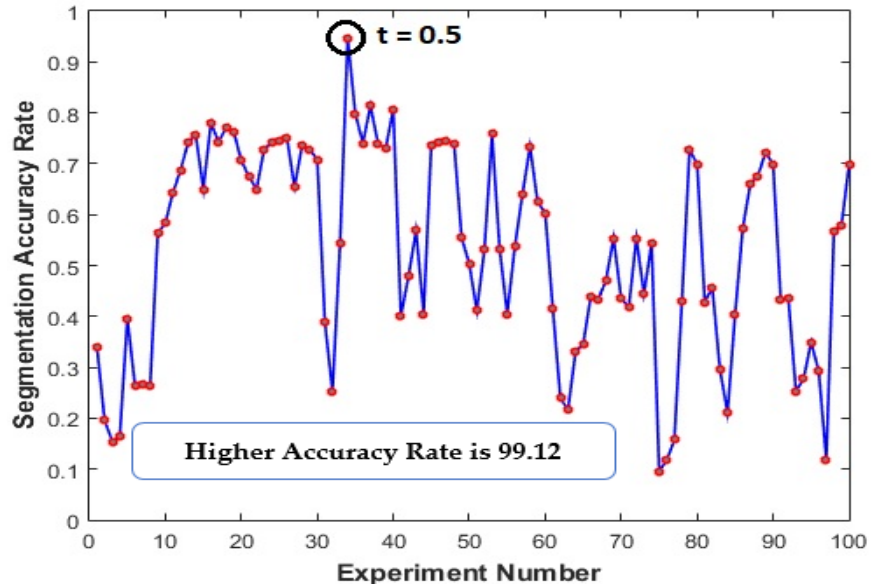
Figure 11. The segmentation accuracy obtained during 100 experiments to find the best value of the parameter ( t ) in the using the proposed trainable filters algorithm.